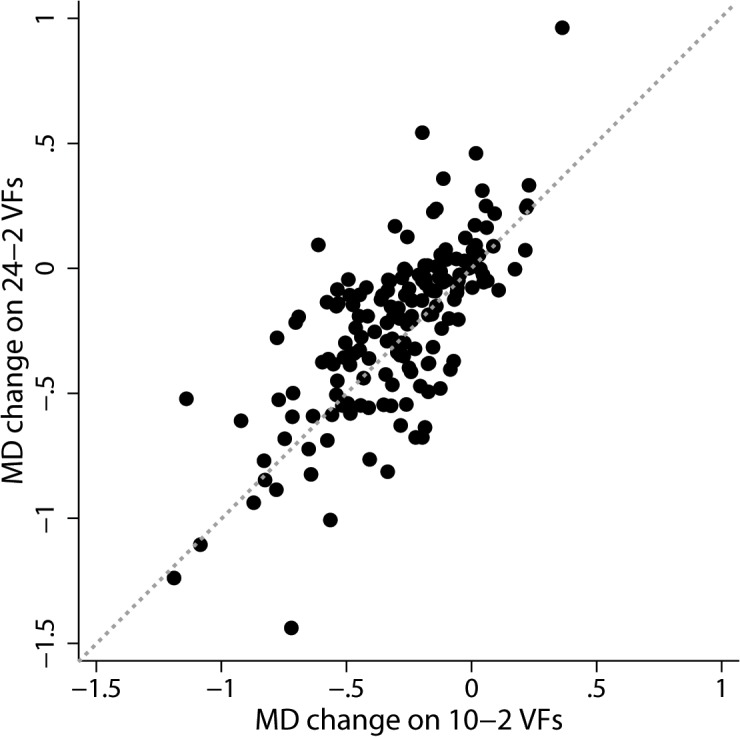
Rate of mean deviation (MD) change on 10–2 and 24–2 visual fields.Scatterplot showing the rate of MD change on 24–2 and 10–2 visual fields (VFs) in individual eyes.